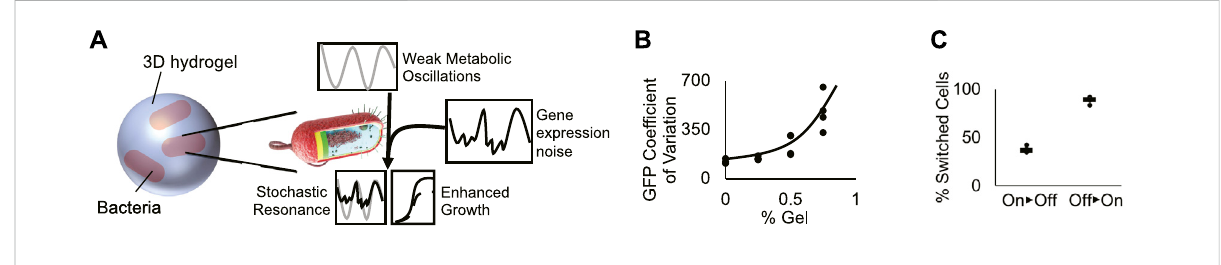
FIGURE 4 Aconceptualmodelgeneratesfrequency-dependentbacterialgrowth. (A) Cartoonoftheproposedmodelofbacterialstochasticresonance.At a speci fi c shaking frequency, weak metabolic oscillations resonate with stochastic fl uctuations in TetX production, boosting growth in tetracycline- treated bacteria. (B) Coef fi cient of variation of bacterial GFP expression in hydrogel. Graph shows that increased hydrogel density increases the variability of genetic module expression. Points represent individual replicates, line highlights trend. Four replicates per condition. Line highlightsthetend. (C) Quanti fi cationof “ on ” and “ off ” cellularpopulationsthatgrewfromcellssortedintheoppositestate.Resultssuggestthatgene expression can switch between “ on ” and “ off ” expression modes. Points represent individual replicates. Lines represent the median proportion of switched bacteria. Four replicates per